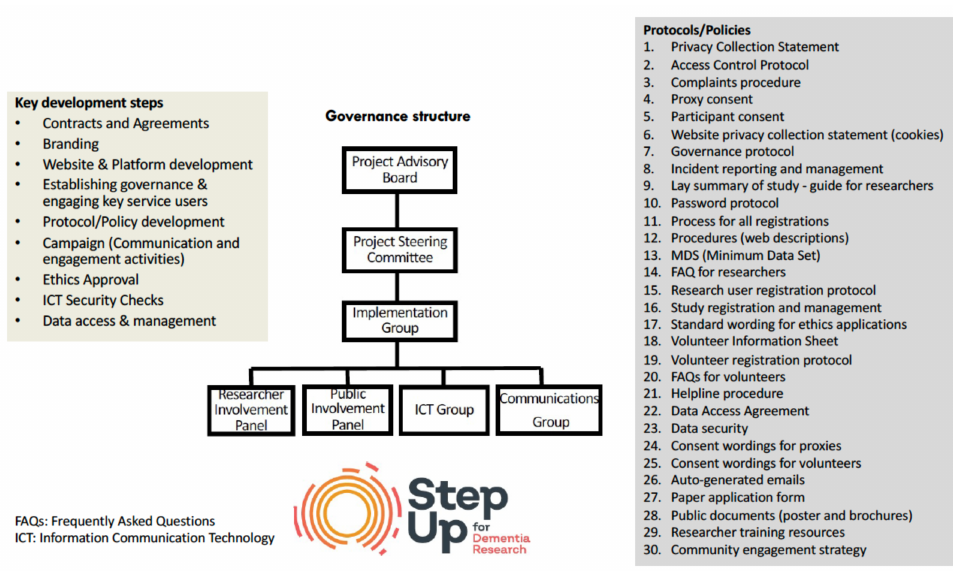
Figure 2. StepUp for Dementia Research development, governance and